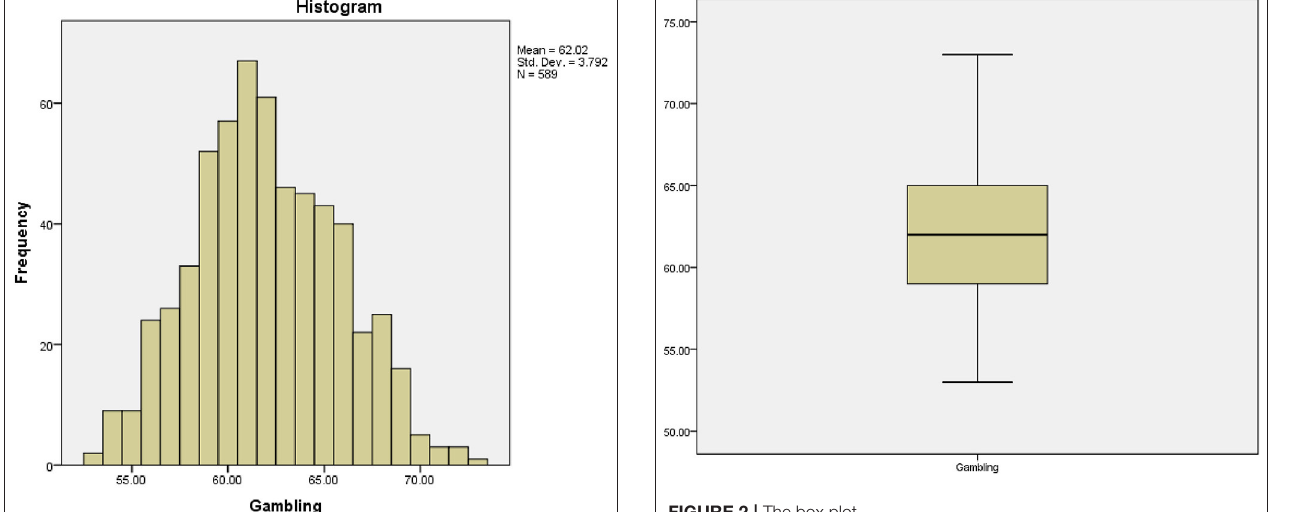
scatterplots are used to measure individual variables while Mahalanobis distance is used to measure for multiple variables.